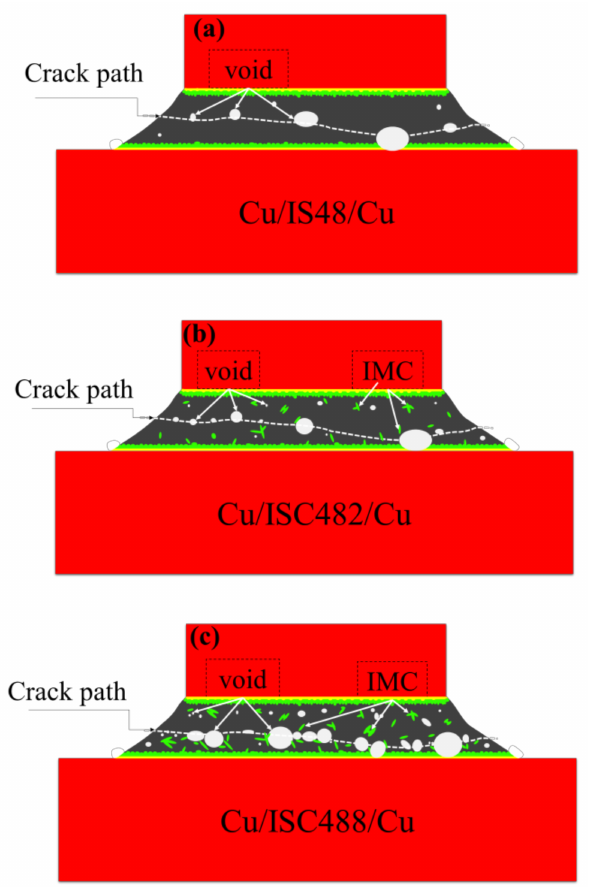
Figure 12. Schematics of crack propagation and void distribution in ( a ) Cu/IS48/Cu, ( b ) Cu/ISC482/Cu, and ( c ) Cu/ISC488/Cu